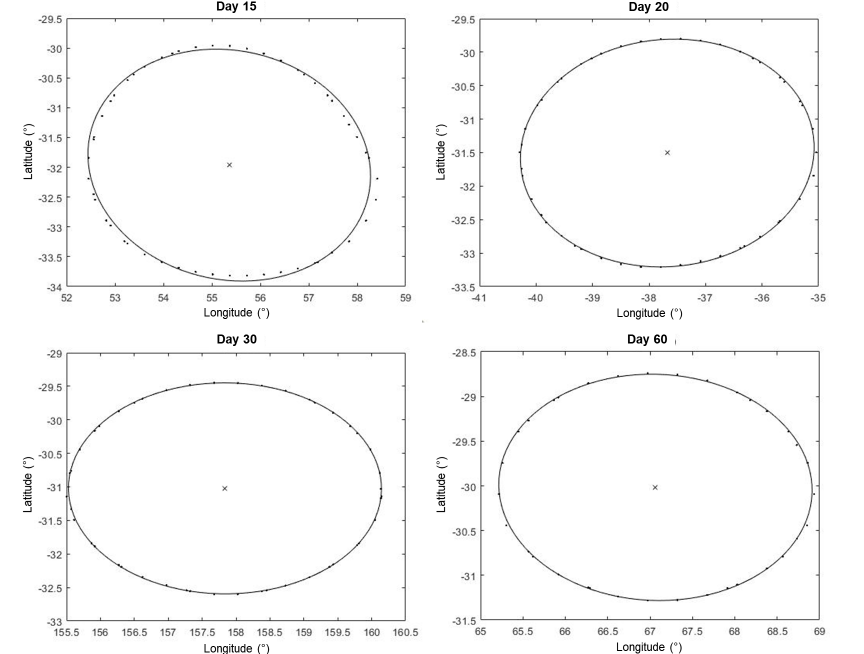
Figure 5. Elliptical vortex fits of closed potential vorticity contours at 700 hPa for Simulation